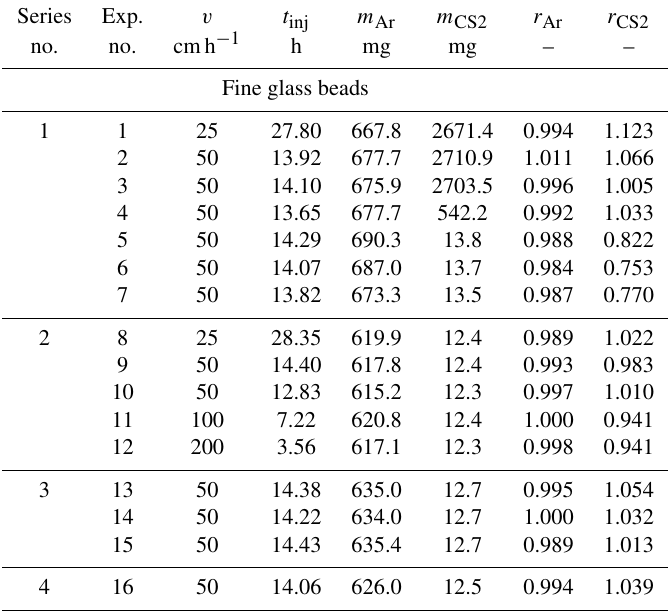
Table B1. Experimental conditions of vapor-retardation experiments in fine glass beads: series, experiment, theoretical seepage velocity, injection duration, and injected mass and recovery of CS 2 and argon.